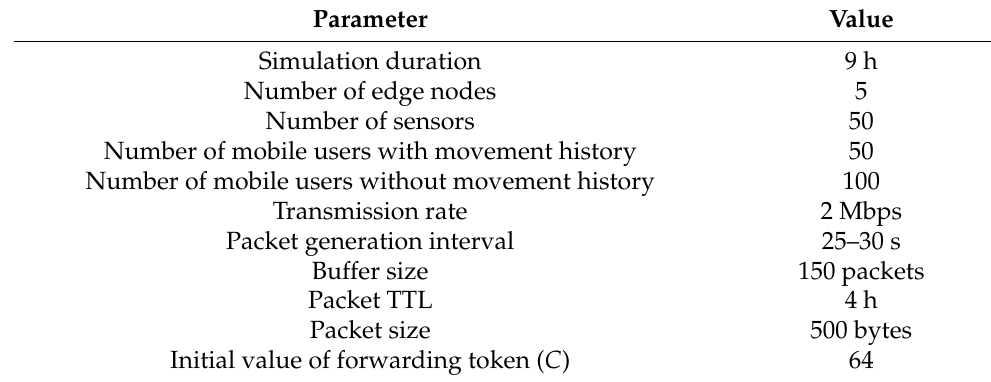
Table 3. Simulation parameters.